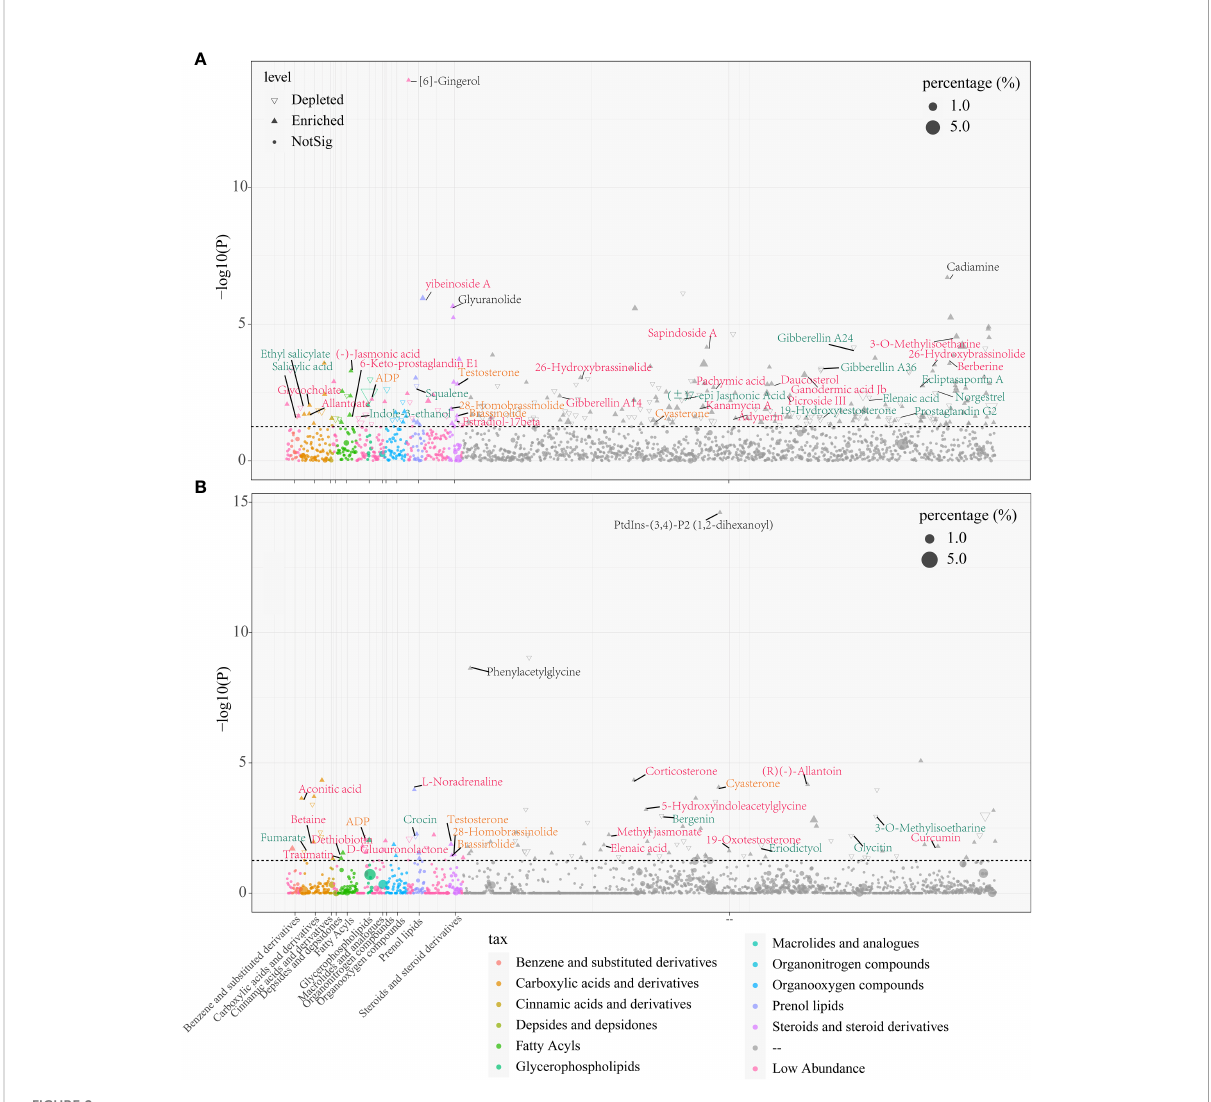
FIGURE 2 Manhattan plot showing differences in metabolites between the male and female papaya in the roots and rhizosphere soils, (A) papaya roots; (B) papaya rhizosphere soils. Each point represented a metabolite, and its size depicted the relative abundance of the metabolite, and the colors of the point denoted the metabolite categories. The P threshold of the dotted line was about 1.30 [-log10 (0.05)], and metabolites above the dashed line represents the metabolites with signi fi cant differences between males and females. The upward triangles showed that the metabolites of the males were signi fi cantly higher than those of the females, while the downward triangles of the males represented signi fi cantly lower metabolites than those of the females. Each dot signi fi ed no difference in substance between the males and females. Metabolites in black font were the ones with the highest change fold. Red font indicated metabolites that were signi fi cantly enriched in the males. Orange font indicated metabolites that were signi fi cantly increased in both roots and rhizosphere soils of the male, while green font indicated metabolites that were signi fi cantly lower in the males. “–” in taxonomy indicated metabolites which was not currently classi fi ed in the HMDB database, accounting for more than 75% of the total amount of substances